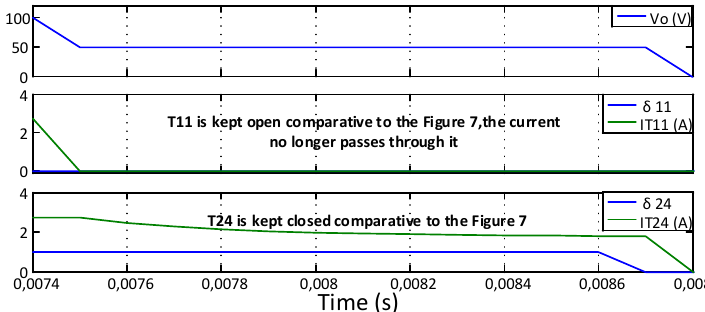
Electronics 2019 ,12, x; doi: FOR PEER REVIEW Figure 16. Voltage V o , currents IT11 and IT24, and switching patterns δ 11 and δ 24 (Zoom 2). Figure 16. Voltage V o , currents IT11 and IT24, and switching patterns δ 11 and δ 24 (Zoom 2). Figure 16. Voltage V o , currents IT11 and IT24, and switching patterns δ 11 and δ 24 (Zoom 2).